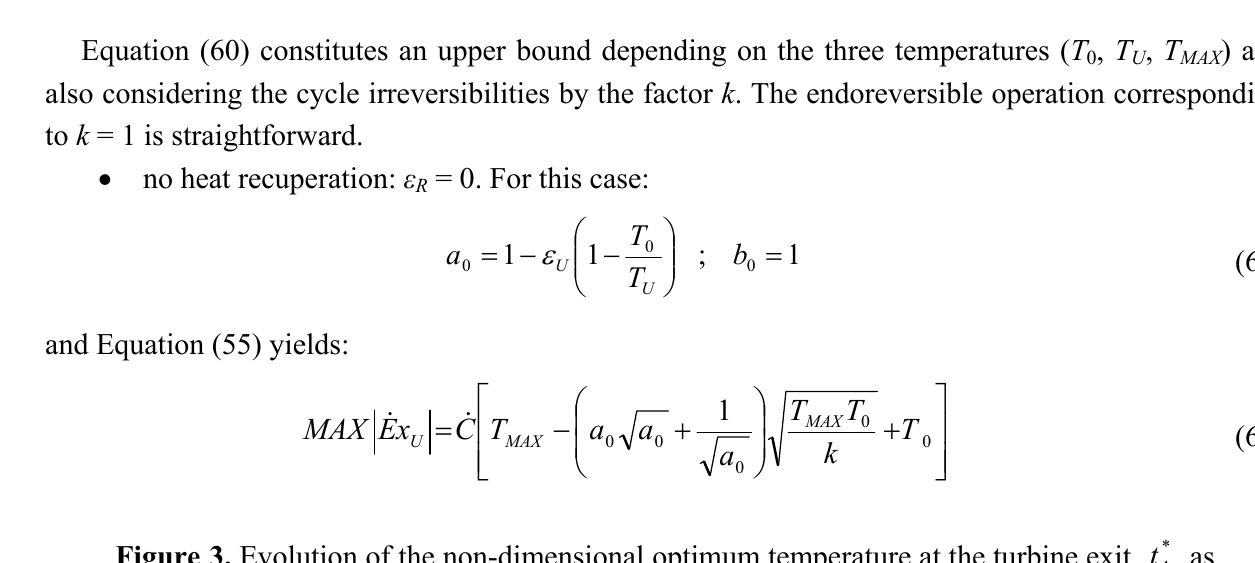
Figure 3. Evolution of the non-dimensional optimum temperature at the turbine exit, * a function of T for T variable. U MAX